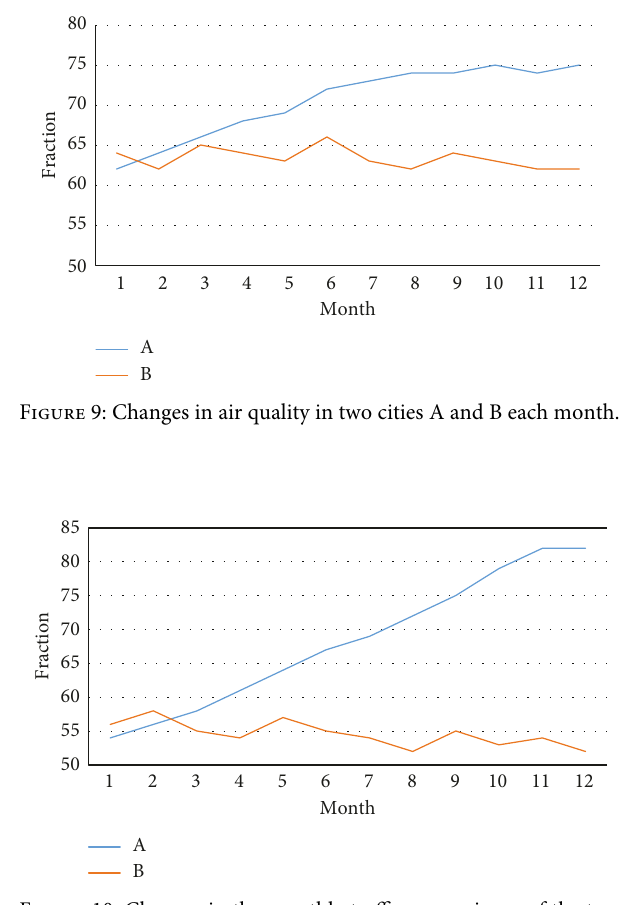
Figure 10: Changes in the monthly traffic convenience of the two cities in A and B.